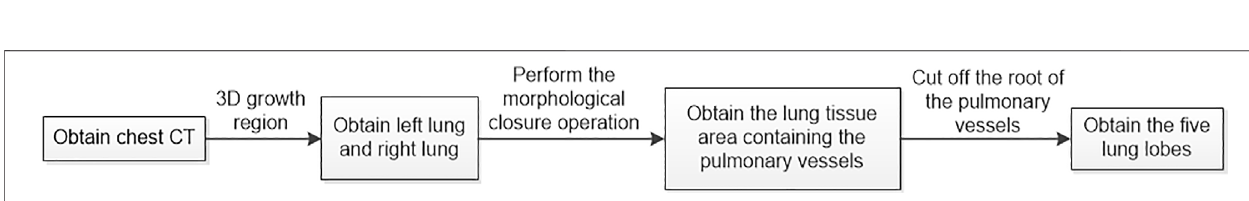
FIGURE1| AnonlineCOVID-19modelingplatformforCOVID-19diagnosis. (A) showsthefunctionof2DCTreading. (B) showsthefunctionof3Dmodelreading.